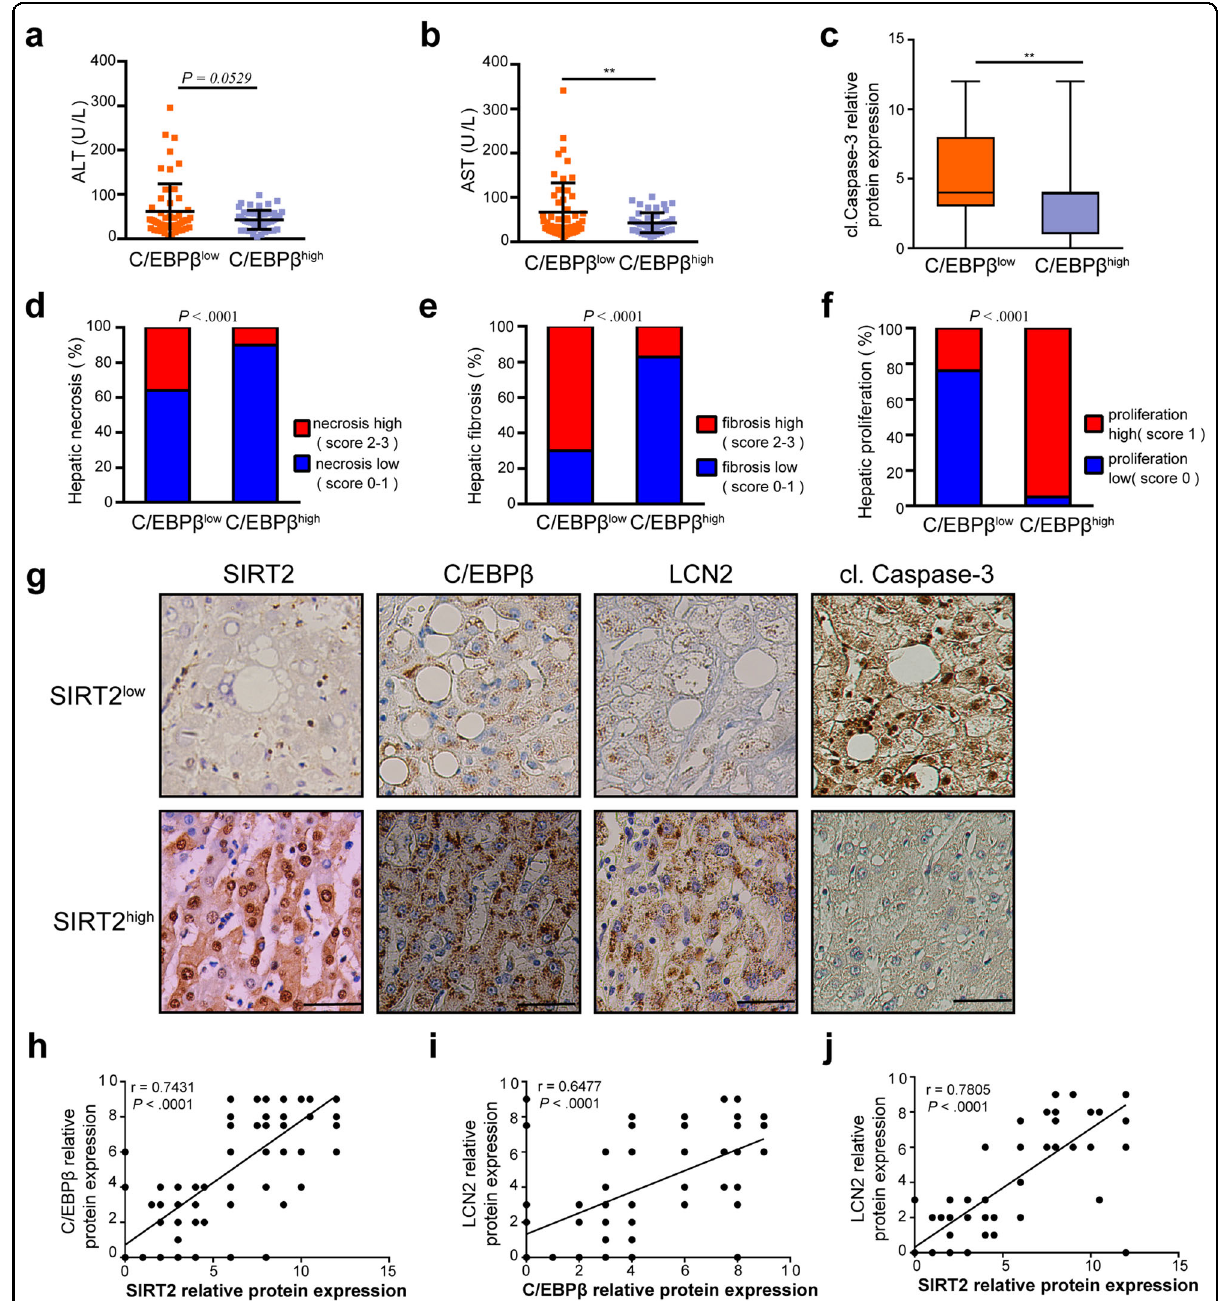
Fig. 8 Hepatic C/EBP β negatively correlates with alcoholic liver injury and positively correlates with SIRT2 and LCN2 expression in patient livers. a – f Plots of serum ALT ( a ) and AST ( b ), cl.Caspase-3 IRS scores ( c ), the percentages of liver tissues with different degrees of necrosis ( d ), fi brosis ( e ), and proliferation ( f ) in ALD patients with high (C/EBP β high , n = 48) and low (C/EBP β low , n = 54) C/EBP β expressions. g Representative IHC images of patient liver samples for the low and high expressions of indicated proteins (scale bar, 100 μ m). h – j Correlation analysis of relative protein expression of SIRT2, C/EBP β , and LCN2 in liver tissues from ALD patients ( n = 102). Statistical signi fi cance was determined by two-tailed Student ’ s t test ( a – c ), Pearson ’ s χ 2 test ( d – f ), and linear correlation and regression ( h – j ). Data are shown as means ± SD and are considered statistically signi fi cant at ** P <